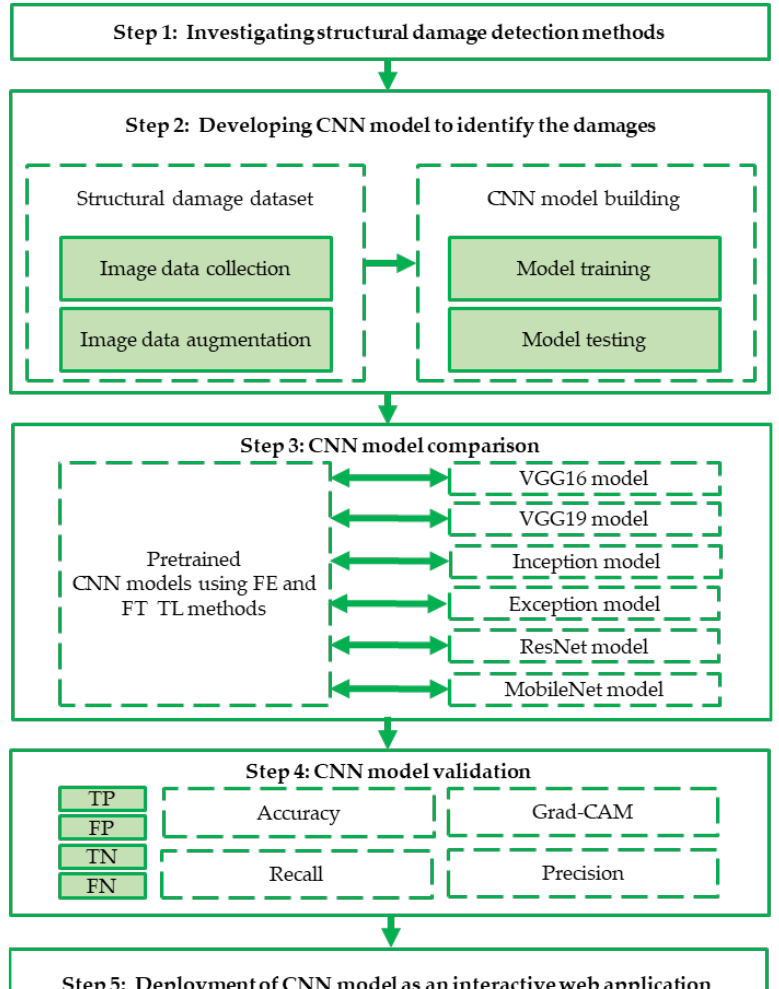
Figure 1. Workflow of the research method used in current study.